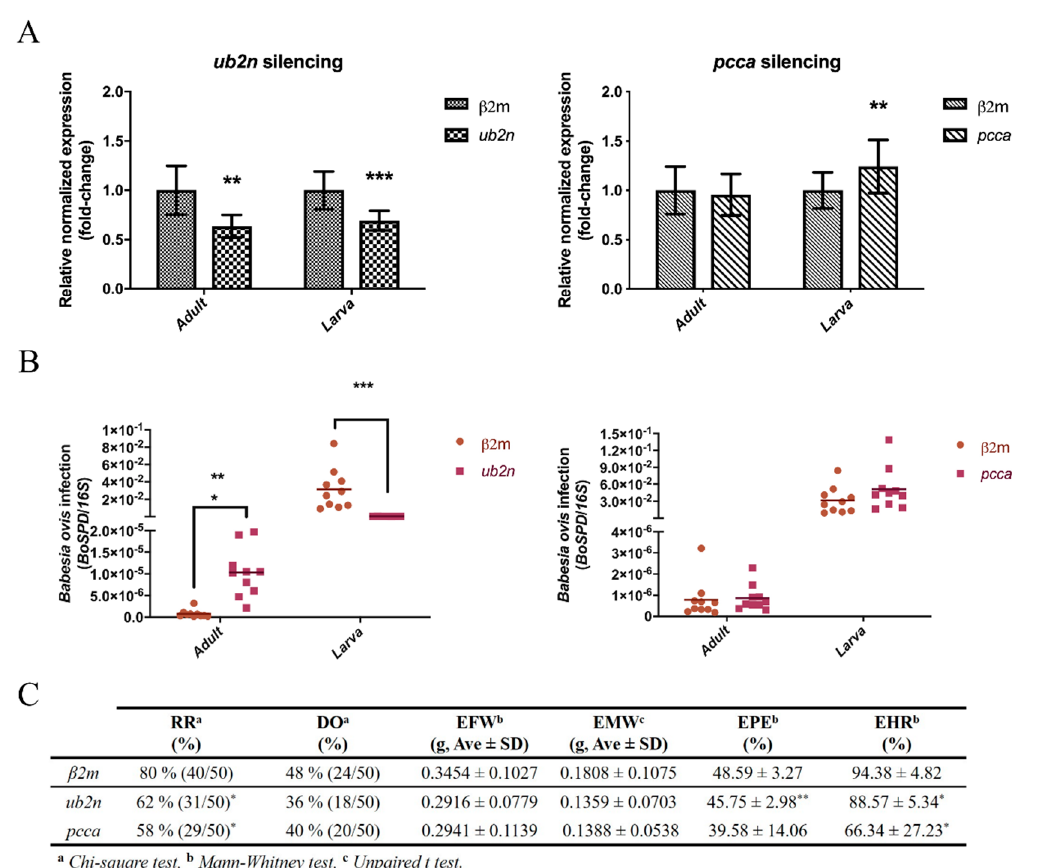
Figure 7. Effect of dsRNA-inoculation in R. bursa during B. ovis infection. ( A ) Gene knockdown assessment by measuring ub2n and pcca relative expressions in dsRNA-inoculated ticks. Data were normalized using 16S rRNA, elongation factor , and β -tubulin reference genes. The expression of β 2m -inoculated group (control) is set to 1 for a better interpretation. Statistical analysis were conducted using the Pfaff method. ( B ) B. ovis infection in salivary glands (Adult) and progeny (Larvae) of dsRNA-inoculated female R. bursa ticks. A ratio between copy number of BoSPD and 16SrRNA for each sample in each condition is represented. Statistical analysis were conducted using the Mann-Whitney test. ( C ) Evaluation of tick biological parameters after dsRNA inoculation. Data are represented as percentage, ratio, means, and standard deviation. Statistical analysis were conducted using the Chi-squared, Mann-Whitney, and Student’s t tests. RR: recovery rate, DO: drop-off, EFW: engorged female weight, EMW: egg mass weight, EPE: egg production efficiency, EHR: egg hatching rate. Significance is represented by * p < 0.05, ** p < 0.01, *** p < 0.001.